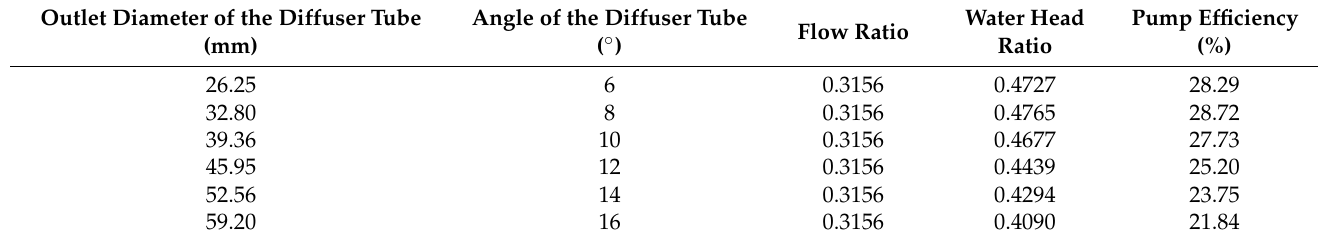
Table 7. Effect of the different angles of the diffuser tube on pump efficiency.